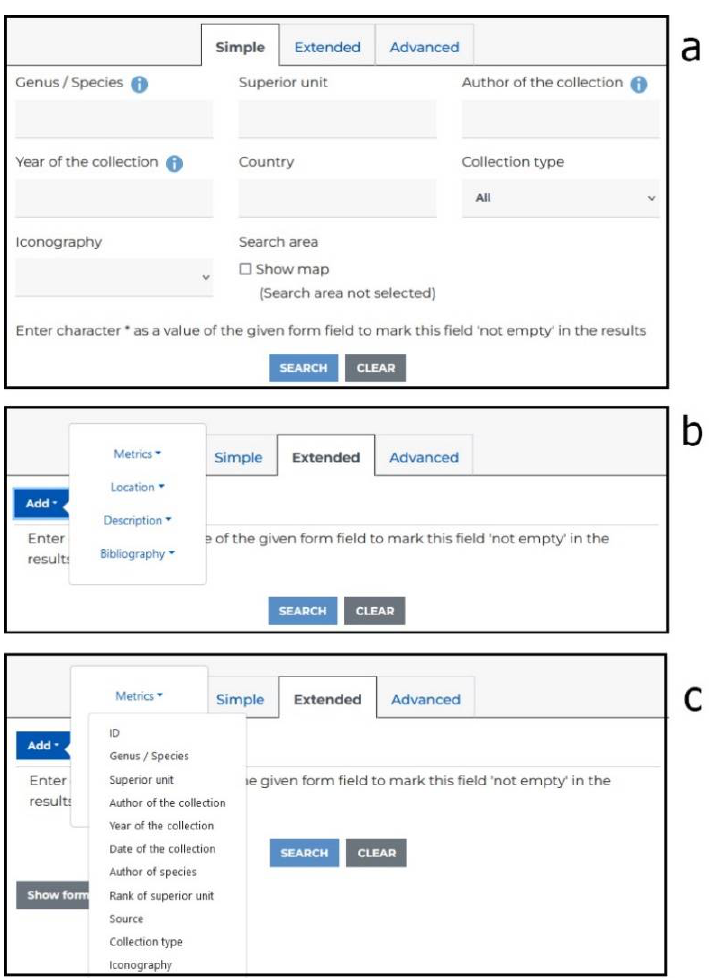
Figure 6. View of specialized search engines of the AMUNATCOLL portal: ( a ) simple search engine, ( b ) extended search engine—criteria groups, and ( c ) extended search engine—a selected criteria group.